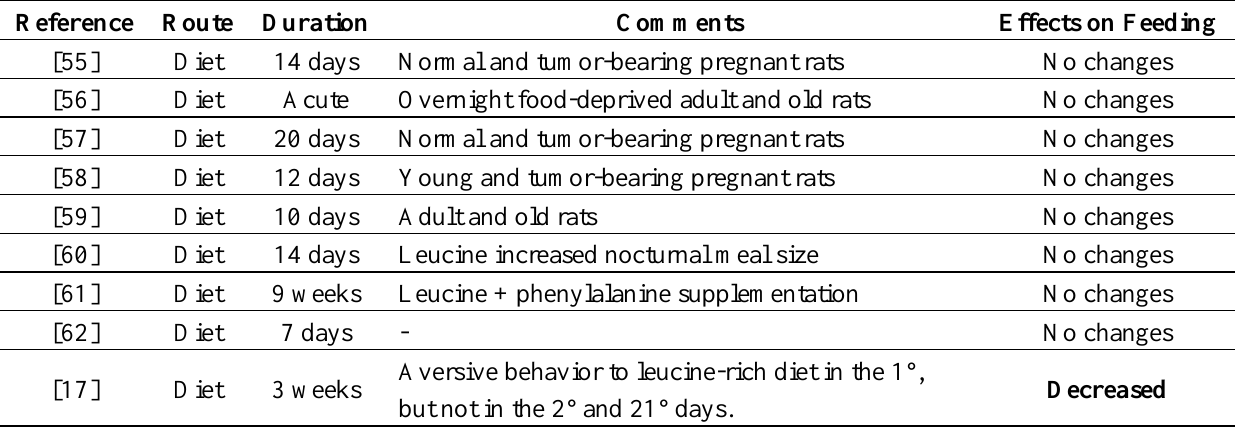
Table 2. Summary of the studies that investigated the effects of leucine supplementation in the diet on